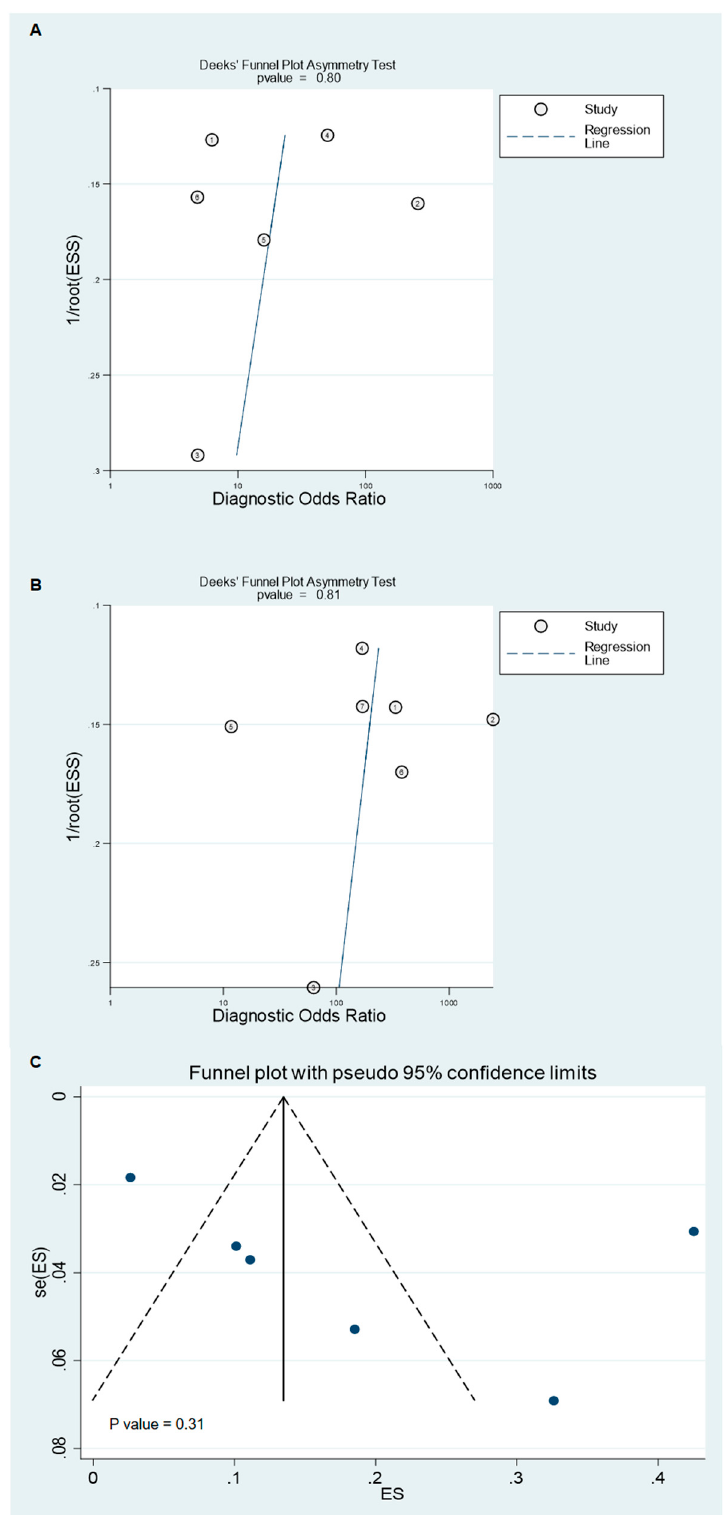
Figure 6. Funnel plots of studies evaluating the diagnostic ability of FDG PET/CT and PET/MRI for detecting lymph node metastasis ( A ), studies evaluating the diagnostic ability of FDG PET/CT and PET/MRI for detecting distant metastasis ( B ), and studies evaluating the proportion of patients who underwent management changes following imaging ( C ).